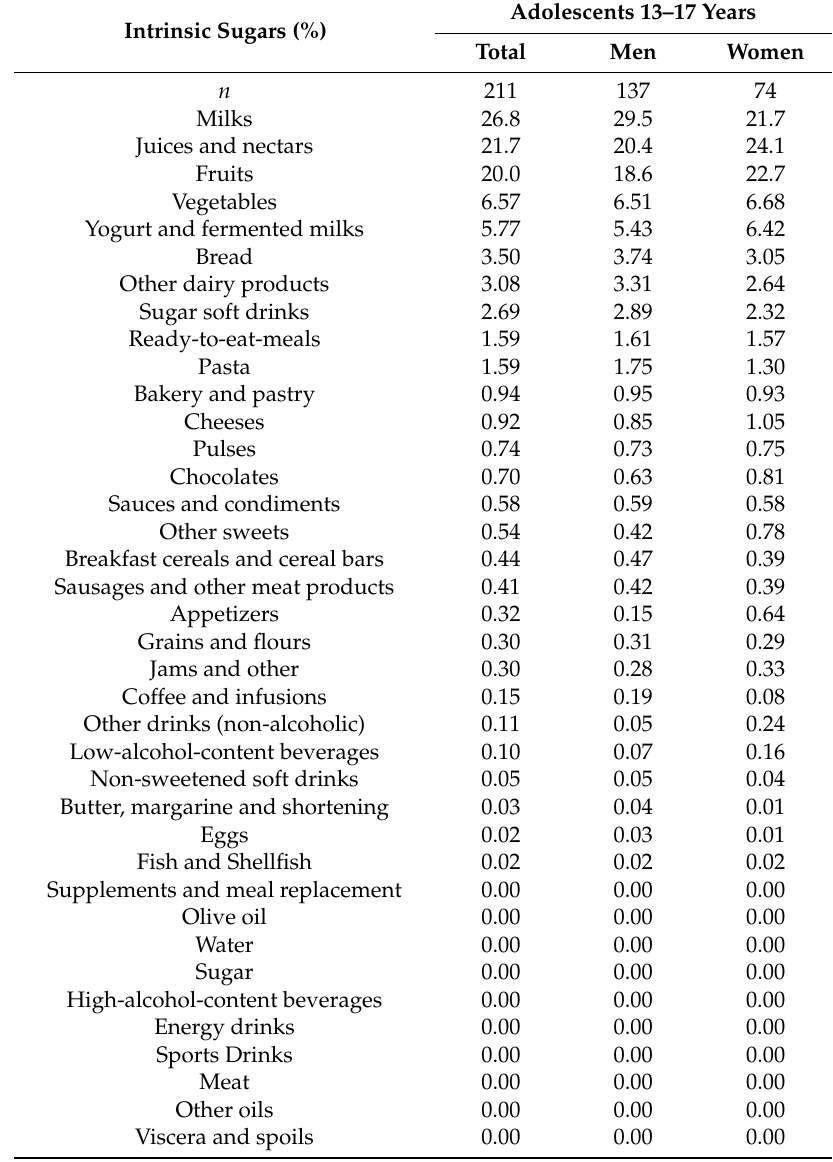
Table 8. Dietary sources of intrinsic sugars (%) from food and beverage subgroups in the ANIBES Study Spanish population aged 13–17 years: